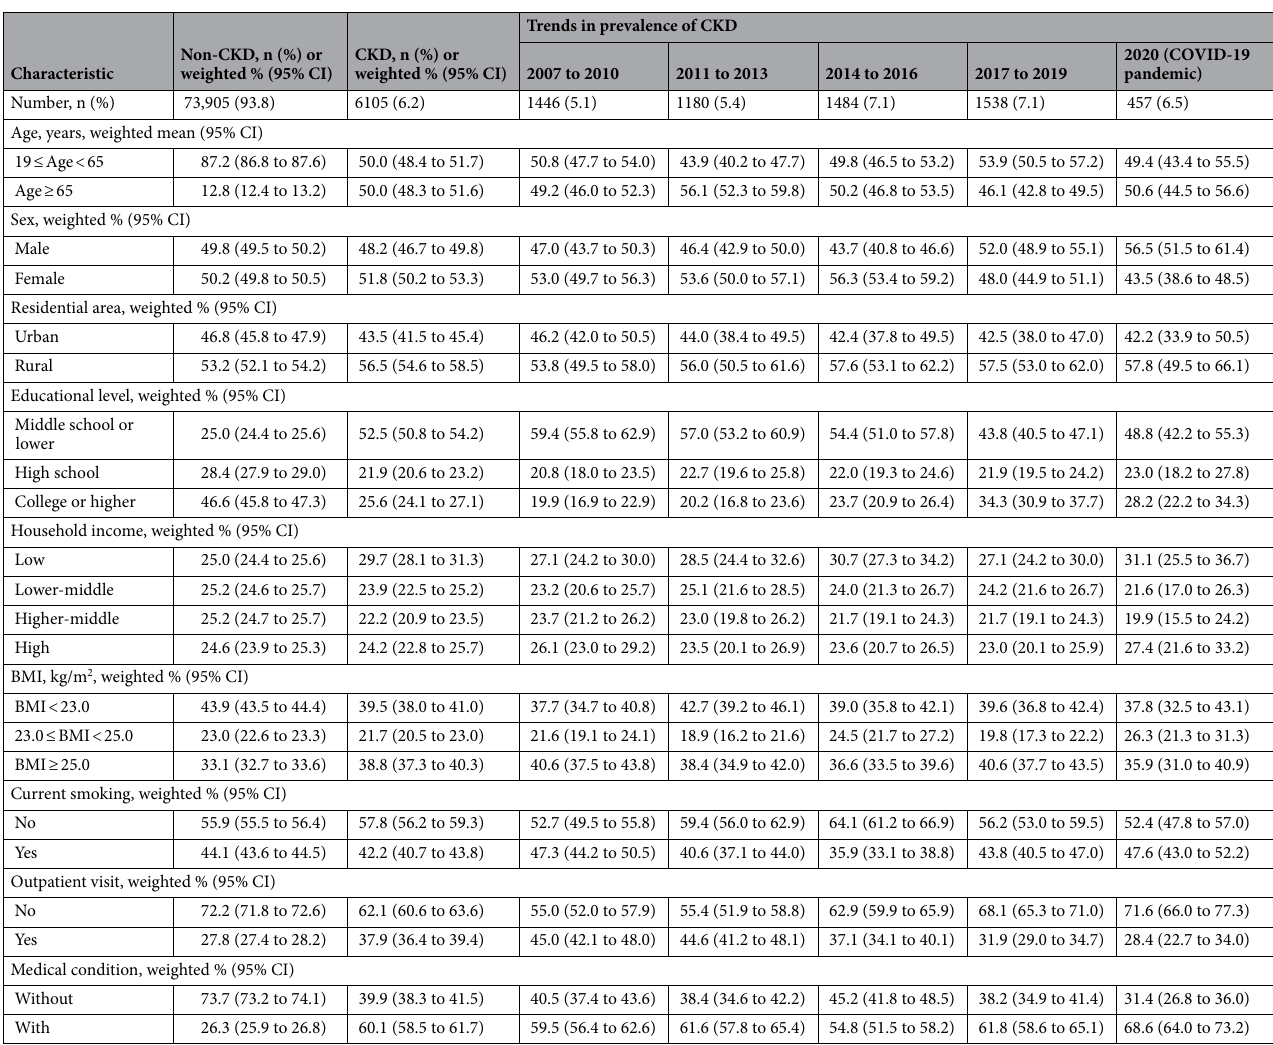
Table 1. Demographic characteristics of participating adults in the KNHANES, 2007–2020 (n = 80,010). BMI body mass index, CKD chronic kidney disease, CI confidence interval, KNHANES Korea National Health and Nutrition Examination